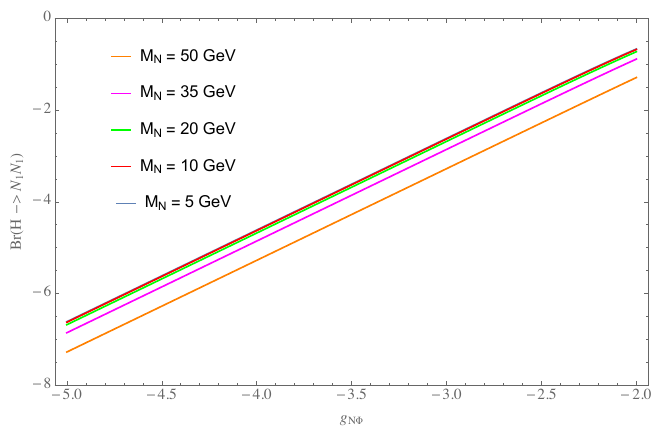
H N 1 N 1 in pb as a function of the heavy neutrino mass, M 1 for ! ! v ( (cid:11) N (cid:8) ) 11 p . 2(cid:3) (cid:17)